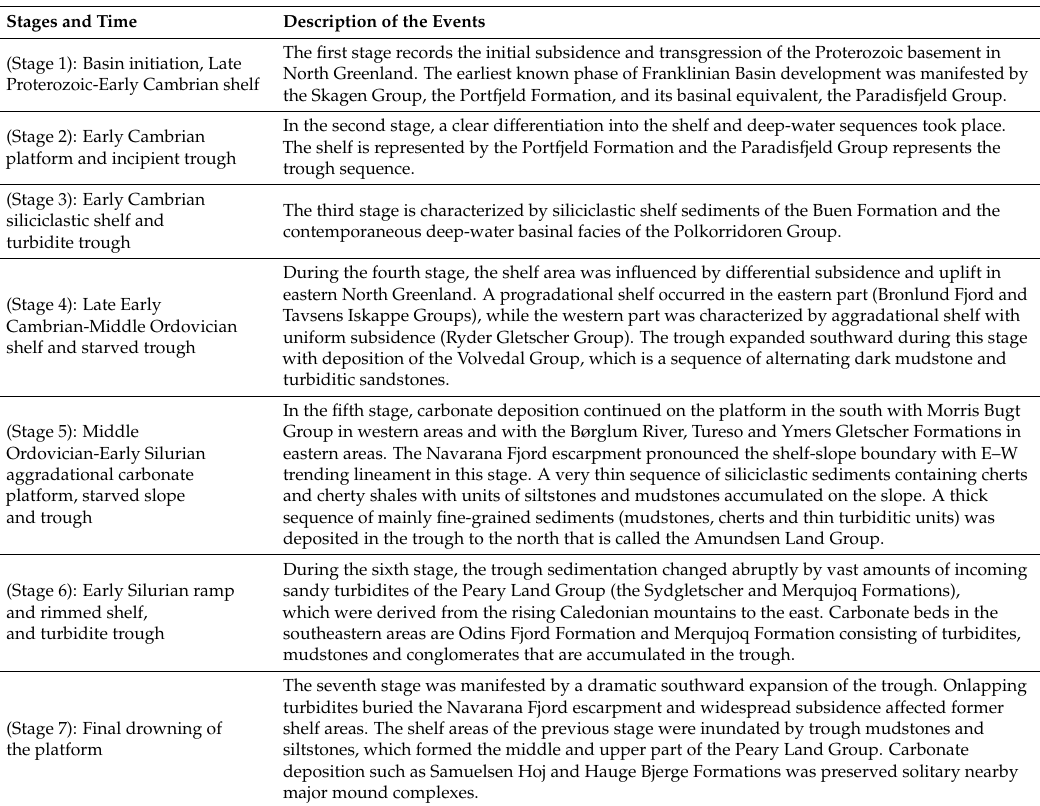
Figure 3. Stratigraphic N–S section of the Franklinian Basin showing transition from shallow-water carbonate shelf to deep-water, sand-and silt-dominated in the trough (Early Cambrian to Silurian) and stratigraphic positions of Zn–Pb occurrences (abbreviations in Figure 2). The development of the basin divided into seven stages; (S) indicates shelf deposits and (T) trough deposits (modified from [3,5,27]). Table 1. The evolution stages of the Franklinian Basin, North Greenland [1,2,4,27–29]. Stages and